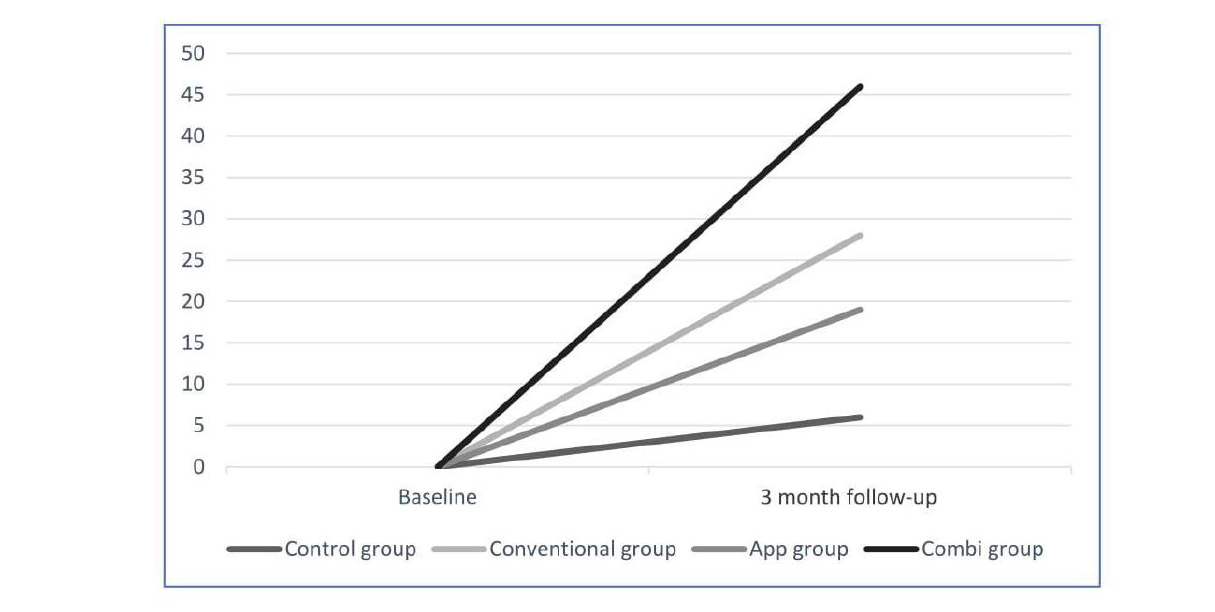
Figure 4. Weight loss (percentage of persons losing 5% of baseline weight).